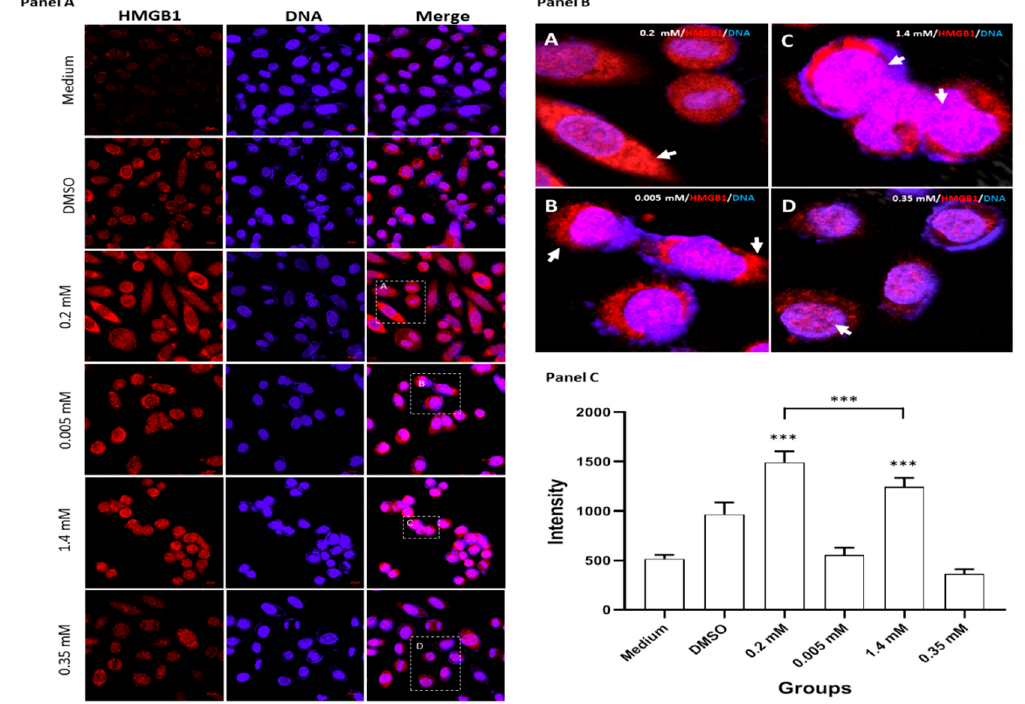
Figure 4. Intracellular location of HMGB1 in SiHa cells in response to treatment with VPA and HO-AAVPA. SiHa cells were stimulated with VPA at 1.4 and 0.35 mM, HO-AAVPA at 0.2 and 0.005 mM for 12 h. In Panel ( A ), is observed HMGB1 which was immunostained with anti-HMGB1 Ab and Alexa 647–conjugated secondary Ab (red) and DAPI to observe the DNA (blue) and the merge to observed the colocalization of HMGB1. In Panel ( B ), is shown the amplified images of the boxes shown in Panel A labeled in squares. The Figure ( A ) and ( B ) in the Panel ( B ) are showing HMGB1/DNA in presence of HO-AAVPA at 0.2 and 0.005 mM, respectively. The figures ( C ) and ( D ) are showing HMGB1/DNA in presence of VPA at 1.4 and 0.35 mM, respectively. It is observed that the cells treated with HO-AAVPA have greater intensity of translocation of HMGB1 from the nucleus to the cytoplasm (white arrows), while for VPA HMGB1, was observed predominantly in the nucleus. In Panel ( C ), is shown the analyses of the fluorescent intensity, where it is observed that the intensity for HMGB1 is statistically higher in cells stimulated with HO-AAVPA (0.2 mM) with respect to VPA (1.4 mM) ( p < 0.001) and both with respect to the vehicle group ( p < 0.001). The graphic shows two independent experiments and the average of 10 cells in the visual field in microscopy (400×). Data are presented as the mean ± SE of intensity. *** p < 0.001vs. DMSO vehicle.